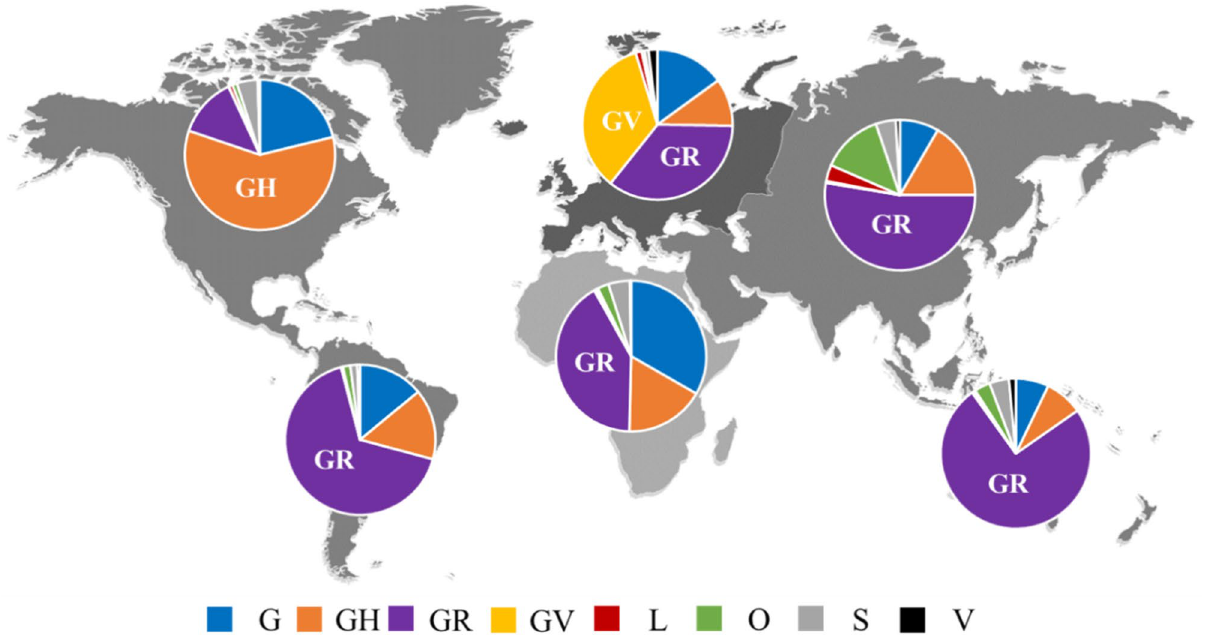
Figure 1. Continent distribution of various SARS-CoV-2 clades. The figure shows the predominance of clade GR in Africa, Asia, Oceania, and South America and the predominance of clade GH in North America. The clades GR and GV predominated in